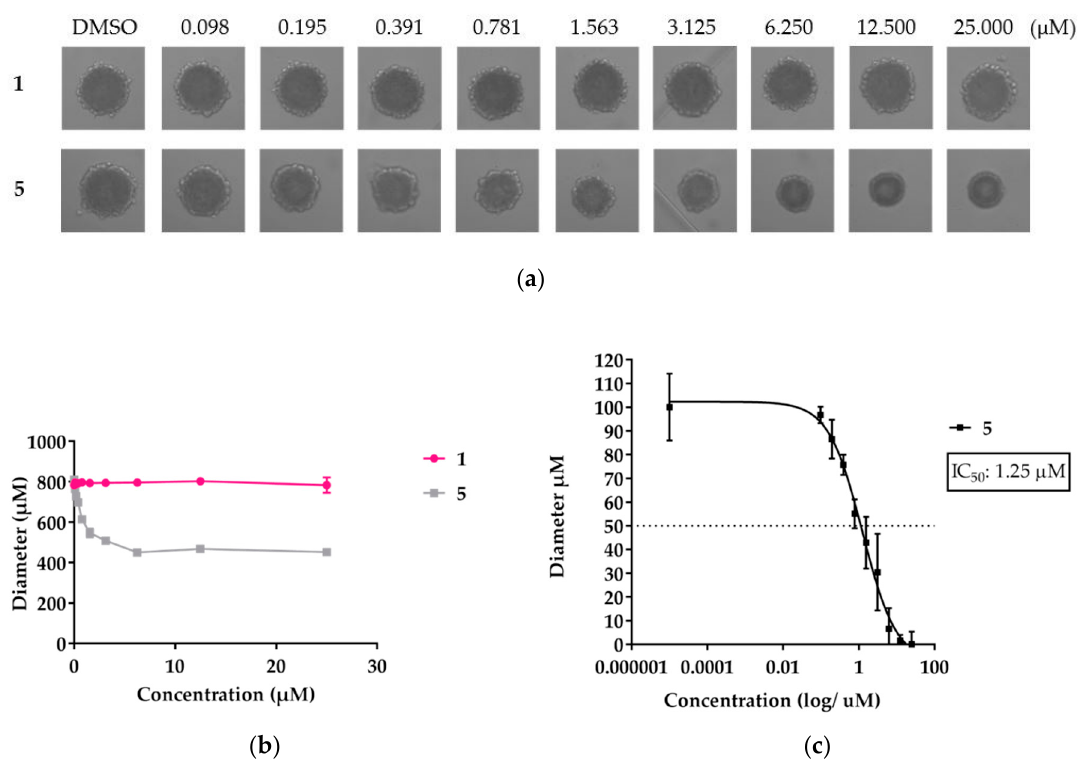
Figure 8. Assessment of spheroid growth on drug-treated MDA-MB-231 spheroids. MDA-MB-231 cells (ER-, PR-, HER2-) were treated for 4 days with 1 and 5 as single-agents. Spheroids were imaged and analysed using the Celigo High Throughput Micro-Well Image Cytometer. ( a ) Representative bright-field images of MDA-MB-231 spheroids after 4 days. ( b ) Diameter of MDA-MB-231 spheroids after 4 days incubation. ( c ) Spheroid diameter dose–response curve for compound- 5 -treated spheroids. Data shown as mean ± SD of triplicate wells and are representative of three independent experiments ( n = 3).